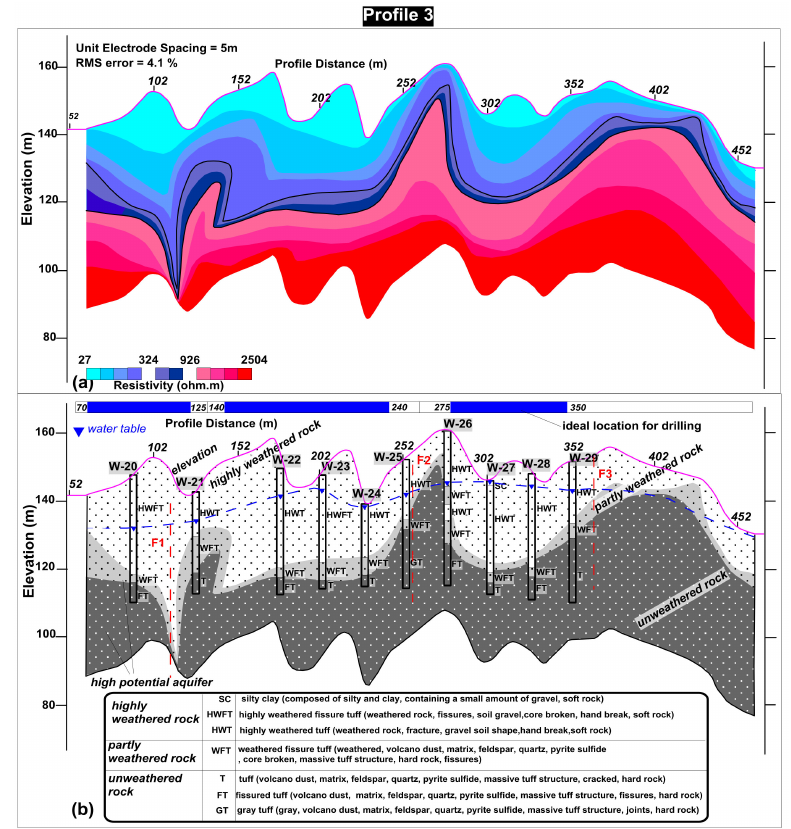
Figure 11. Electrical image along profile 3 ( a ) model resistivity with topography ( b ) interpreted model resistivity with